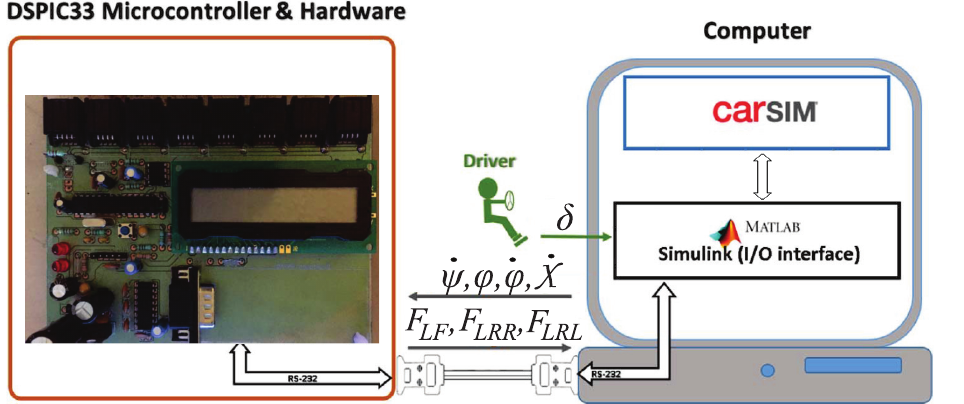
Figure 8. HIL test platform and printed circuit board of the DSC. The vehicle is emulated in CarSim on a PC (Intel I7 with 16 GB RAM); Simulink serves as a communication interface with the external DSC. The DSC prototype includes a DSPIC33F DSP, LCD display, 8 CAN/ECAN-Bus ports and a serial port with their respective interfaces. The DSP operates at 60 MIPS and the RS232 is programmed to operate at 56